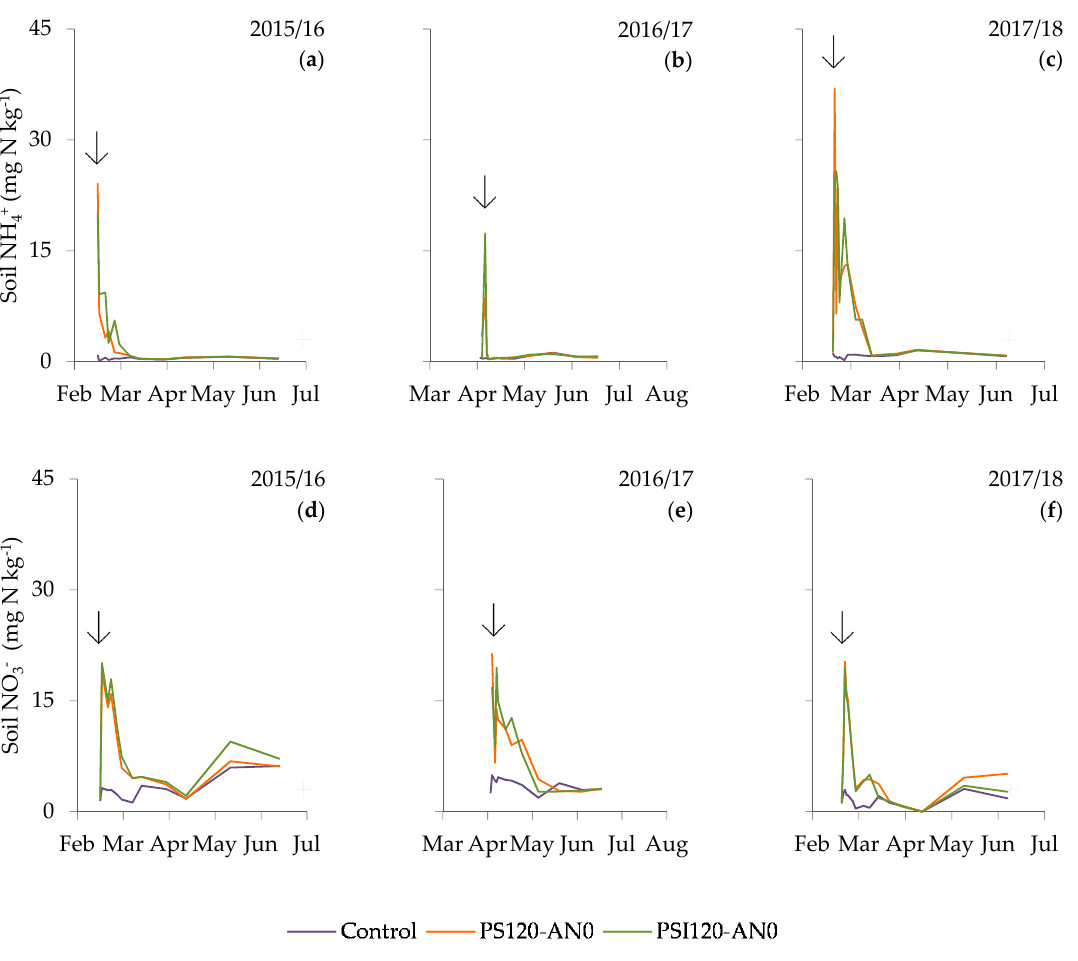
Figure 4. Soil ammonium concentration ( a – c ) and soil nitrate concentration ( d – f ) from 0 to 15-cm depth of the miniplots experiment. Arrows indicate N applications.